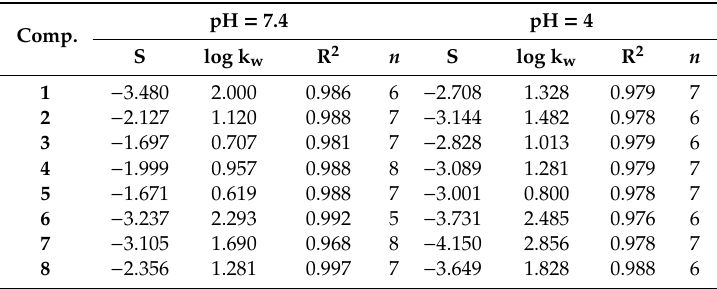
Table 3. Log k w(IAM) and S parameters of Equation (1) for the compounds obtained by IAM chromatography and their in silico descriptors. IAM Comp.